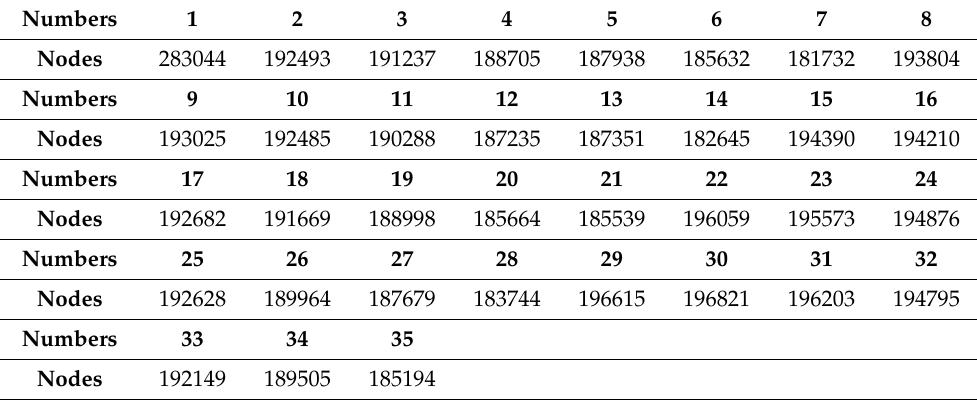
Table A3. Node information corresponding to Figures 16 and